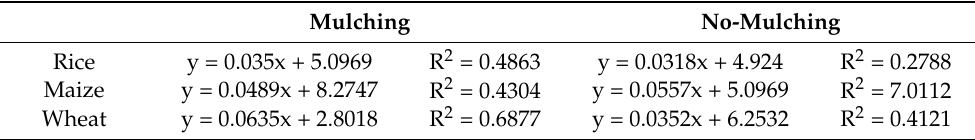
Table 1. Effects of straw mulching and no-mulching with nitrogen application rate on water use efficiency. Adapted with permission from Ref. [140]. 2019, Wang, X.